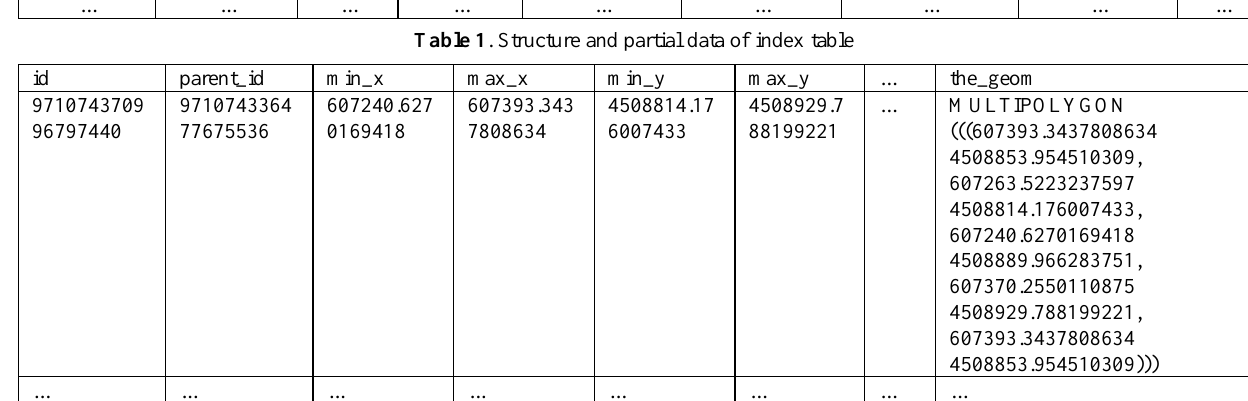
Table 1 . Structure and partial data of index table